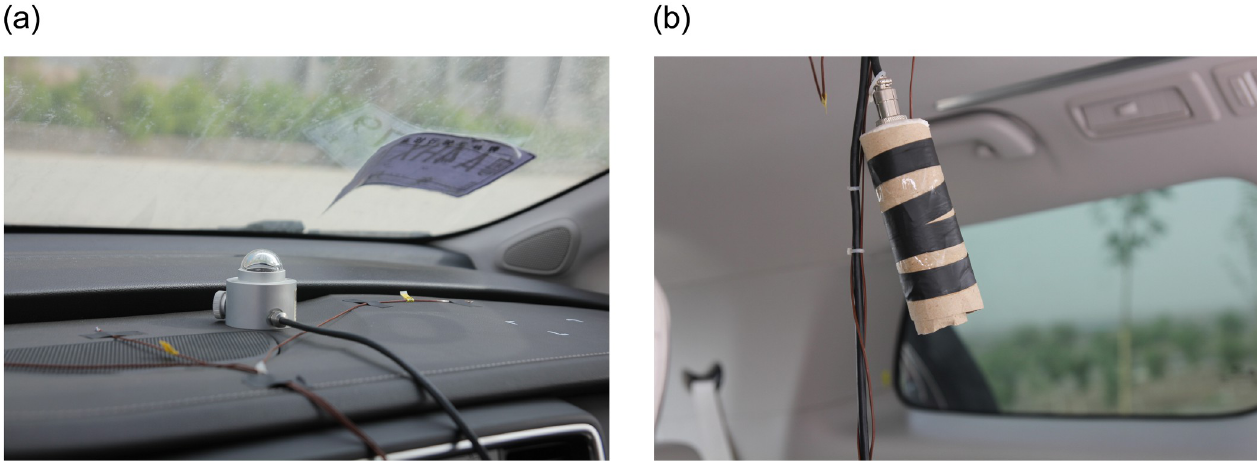
Fig 6. Experimental scenario and related layout. A solar radiation meter was set to obtain the amount of solar radiation entering the cabin through the windows. Air temperature and humidity were measured by a sensor suspended from the roof. (a): Dashboard’s thermocouples and radiometer. (b): Air temperature and humidity sensor.